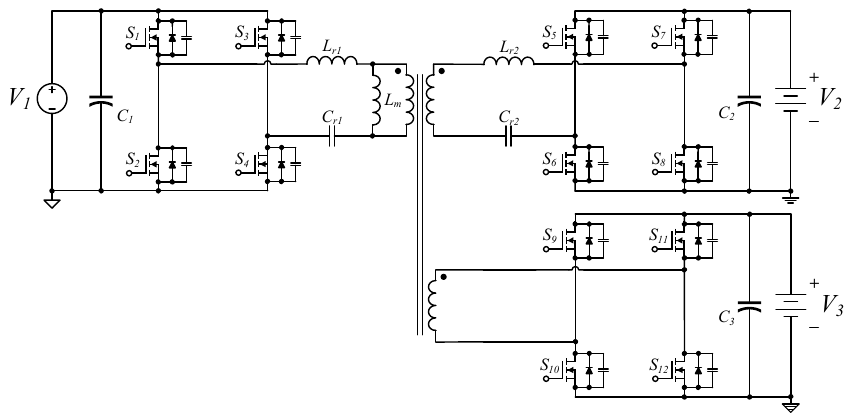
Figure 1. Isolated three-port converter proposed in